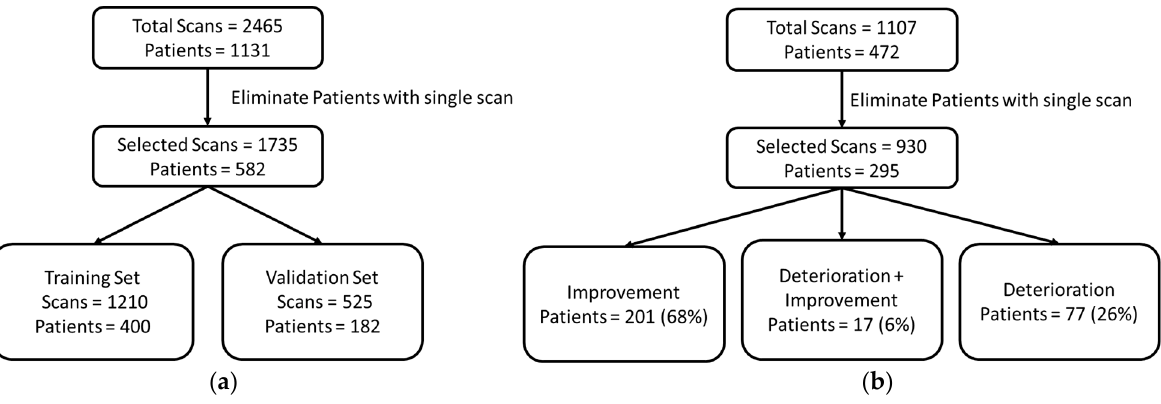
Figure 1. Flowchart of the study population. ( a ) BIMCV dataset used for training and validation of the models, ( b ) COVID chest X-ray dataset for testing the disease progression module.